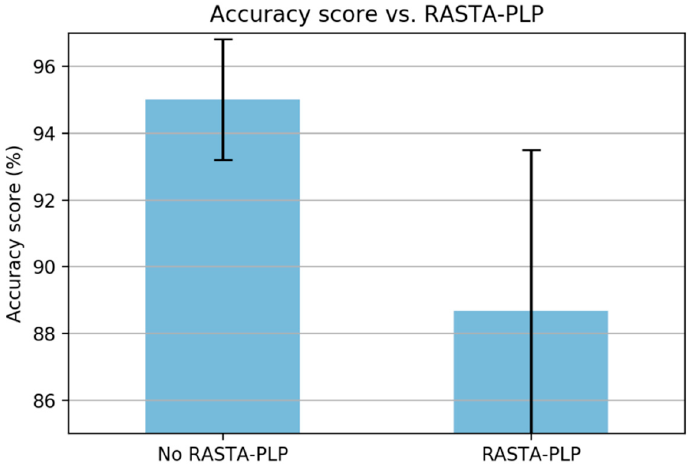
Figure 16. A comparison of the added RASTA filter.